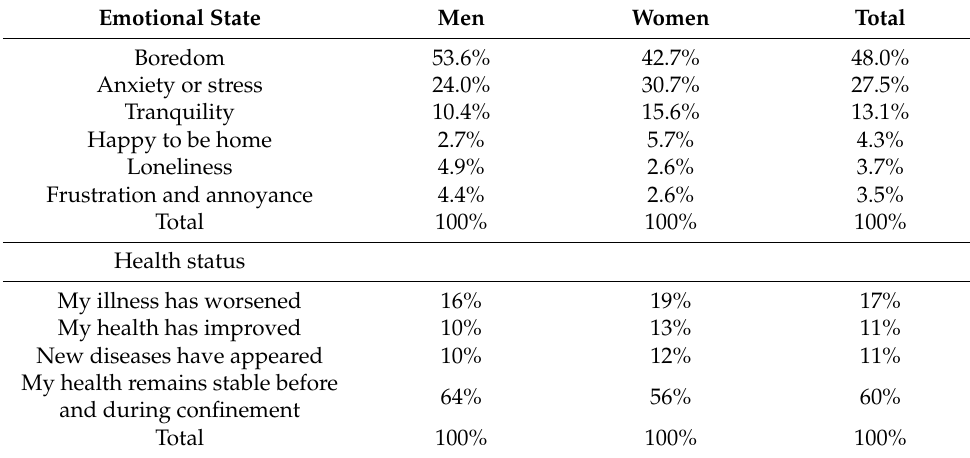
Table 6. Emotional state and health